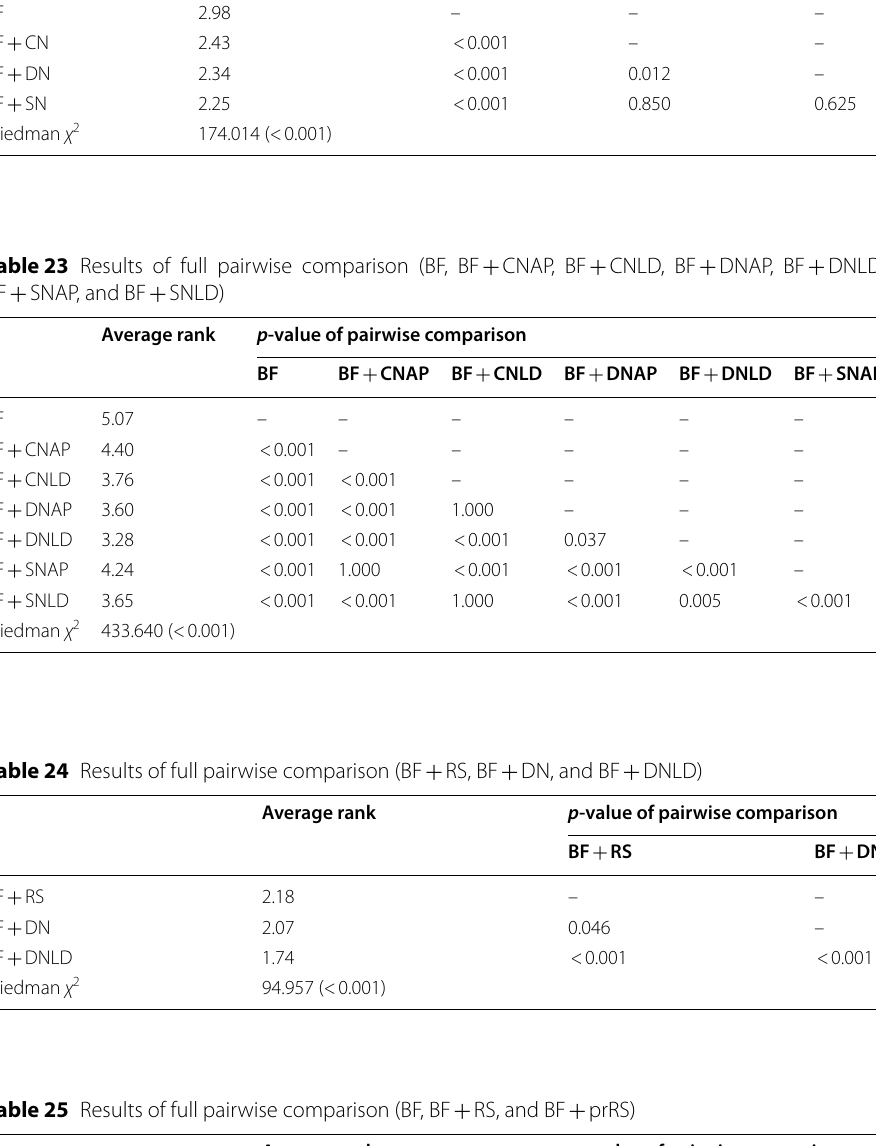
Table 25 Results of full pairwise comparison (BF, BF